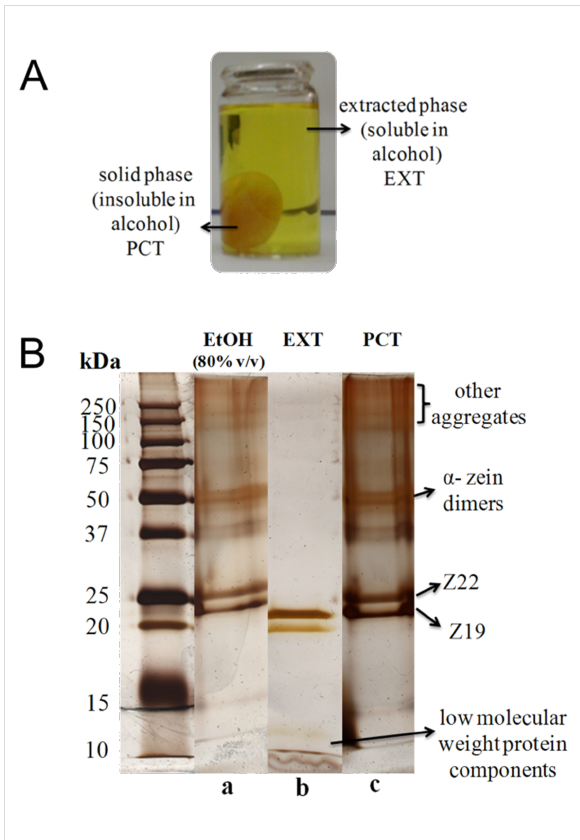
Figure 1: (A) Picture showing the separation phenomenon observed when zein protein is dispersed in absolute ethanol, and (B) SDS-PAGE of zein in 80% (v/v) ethanol/water solution (a) and of the EXT (b) and PCT (c) zein fractions separated in absolute ethanol. PCT was dis- solved in 80% (v/v) ethanol/water for the analysis. The electrophoretic gel was silver